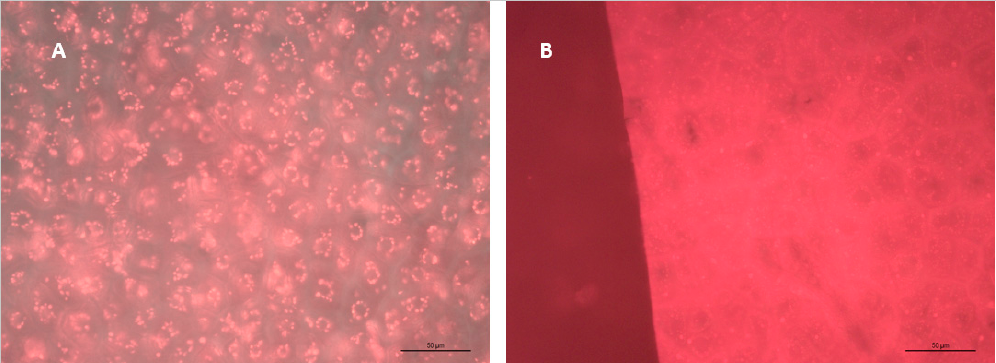
( A ) Day 0 of fermentation, ( B ) Day 14 of fermentation.